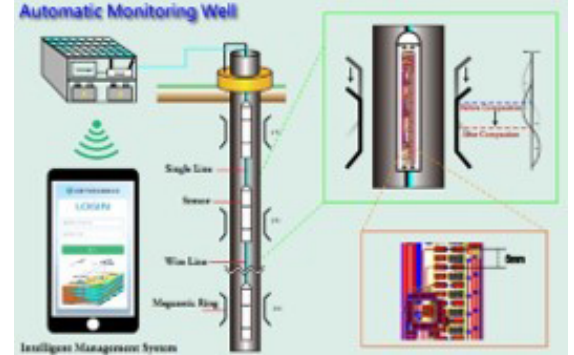
Figure 9. Automatic Multi-layer Compaction Monitoring Well.